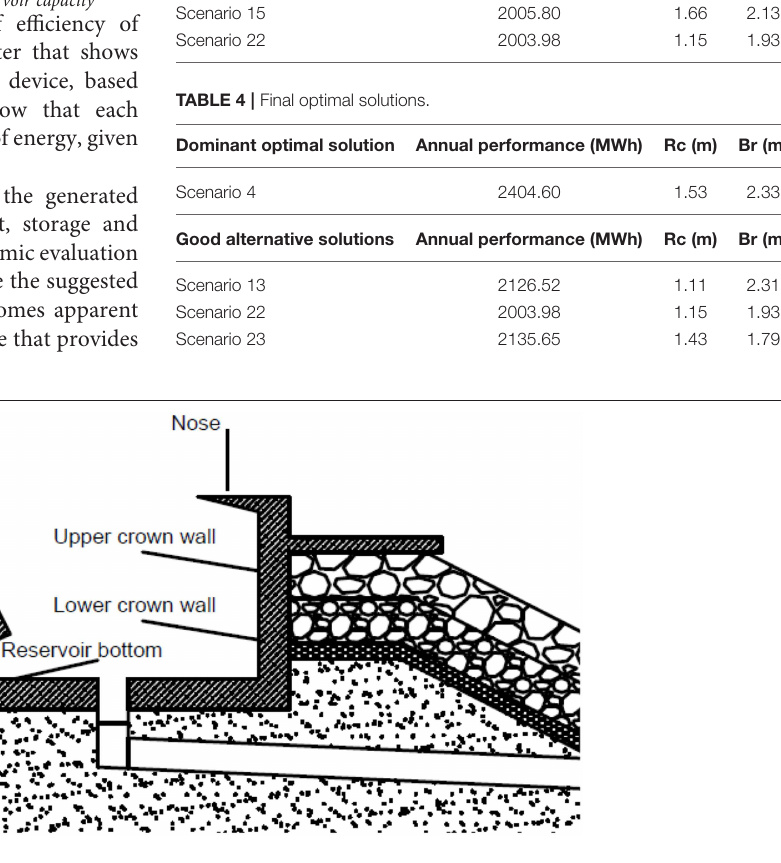
FIGURE 7 | Definition of L OBREC (based on: Contestabile et al., 2015).